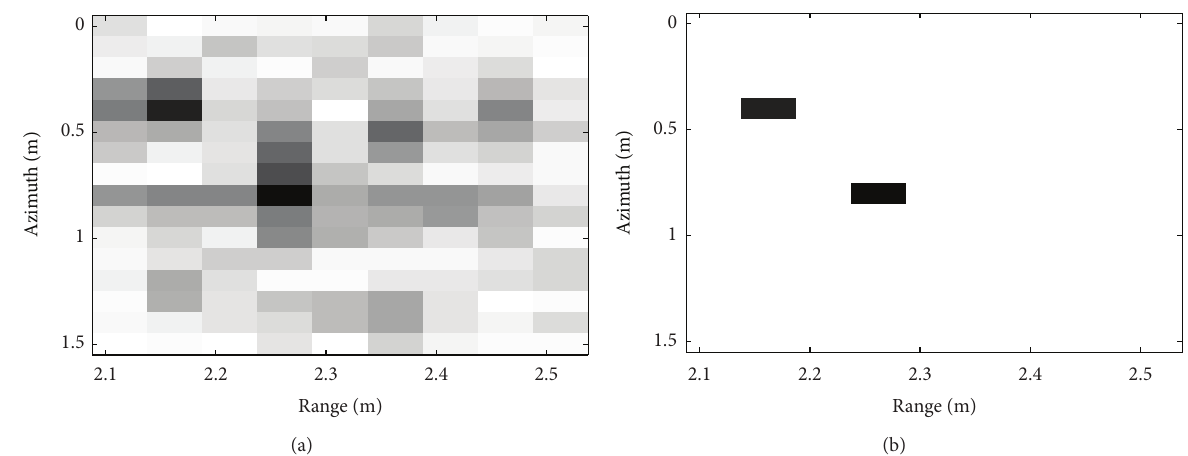
Figure 15: CS reconstructions of the behind-the-wall scene using a point-target dictionary. Downsampling factors were set to 50% for fast- time and 50% for azimuth. (a) 𝑙 1 -norm; (b) OMP.